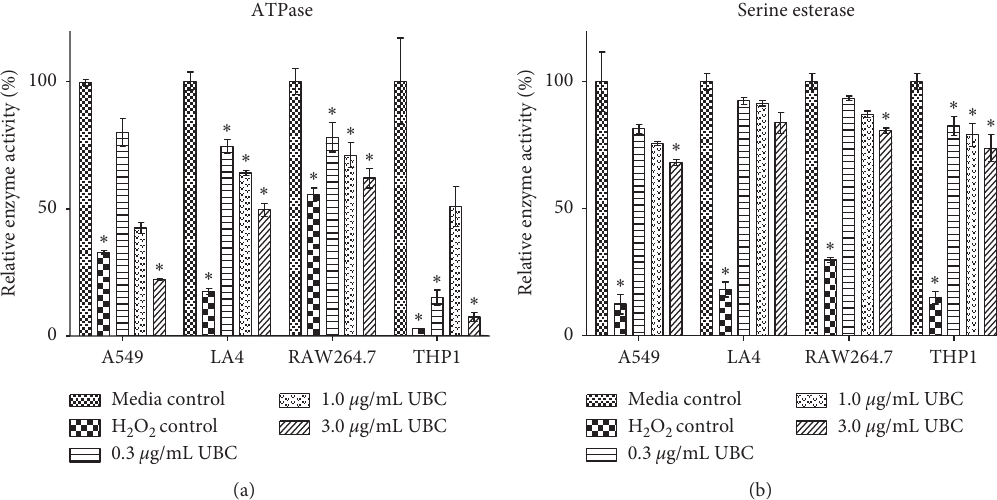
Figure 5: UBC compromises mitochondrial ATPase and cytoplasmic serine esterase activity in a dose-dependent manner across all four cell types. Cells were seeded on day zero then treated with various concentrations of UBC. The cells were harvested and assessed for vitality after day 9 based on (a) mitochondrial ATPase activity (Cell Titer-Glo, Luminescence Assay) and (b) cytoplasmic serine esterase activity (Calcein AM, Fluorescence Assay). Data normalized to the untreated media control and displayed as the mean of six replicate wells ± SE. Normalized activities are indicated as one of five representative independent experiments. Statistically significant at ∗ p < 0 . 05 in comparison to media (untreated)